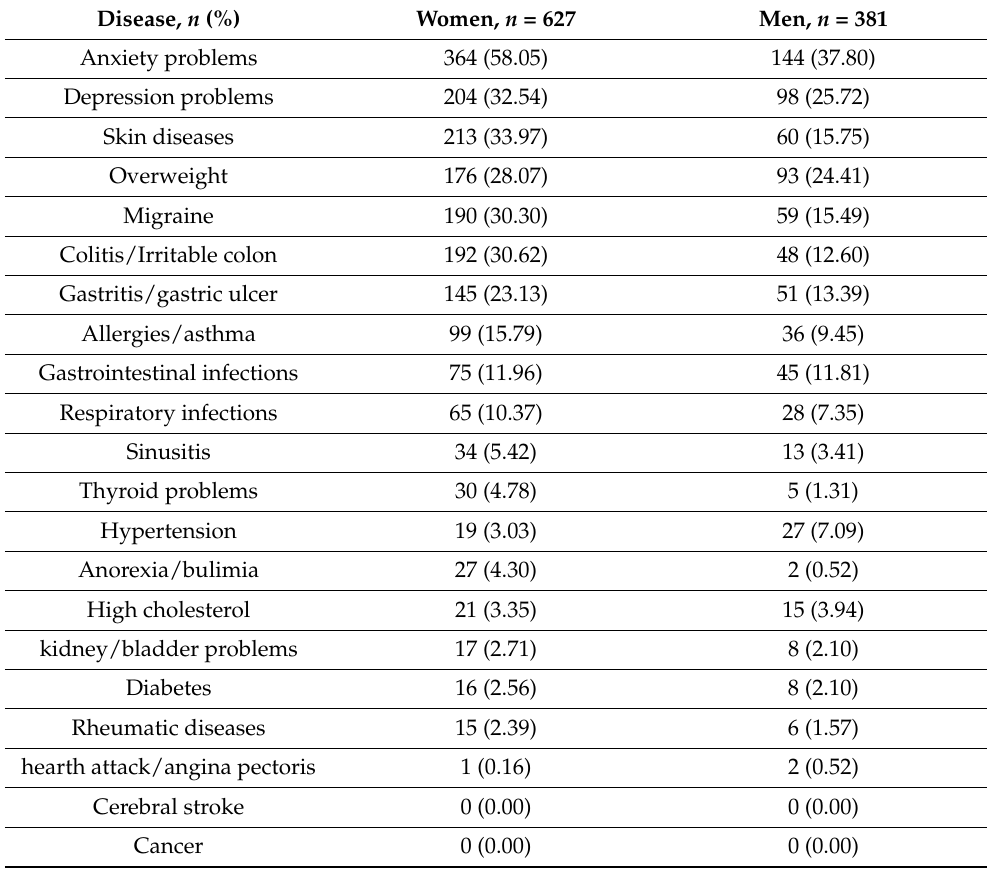
Table 2. Frequency of the self-reported diseases in each